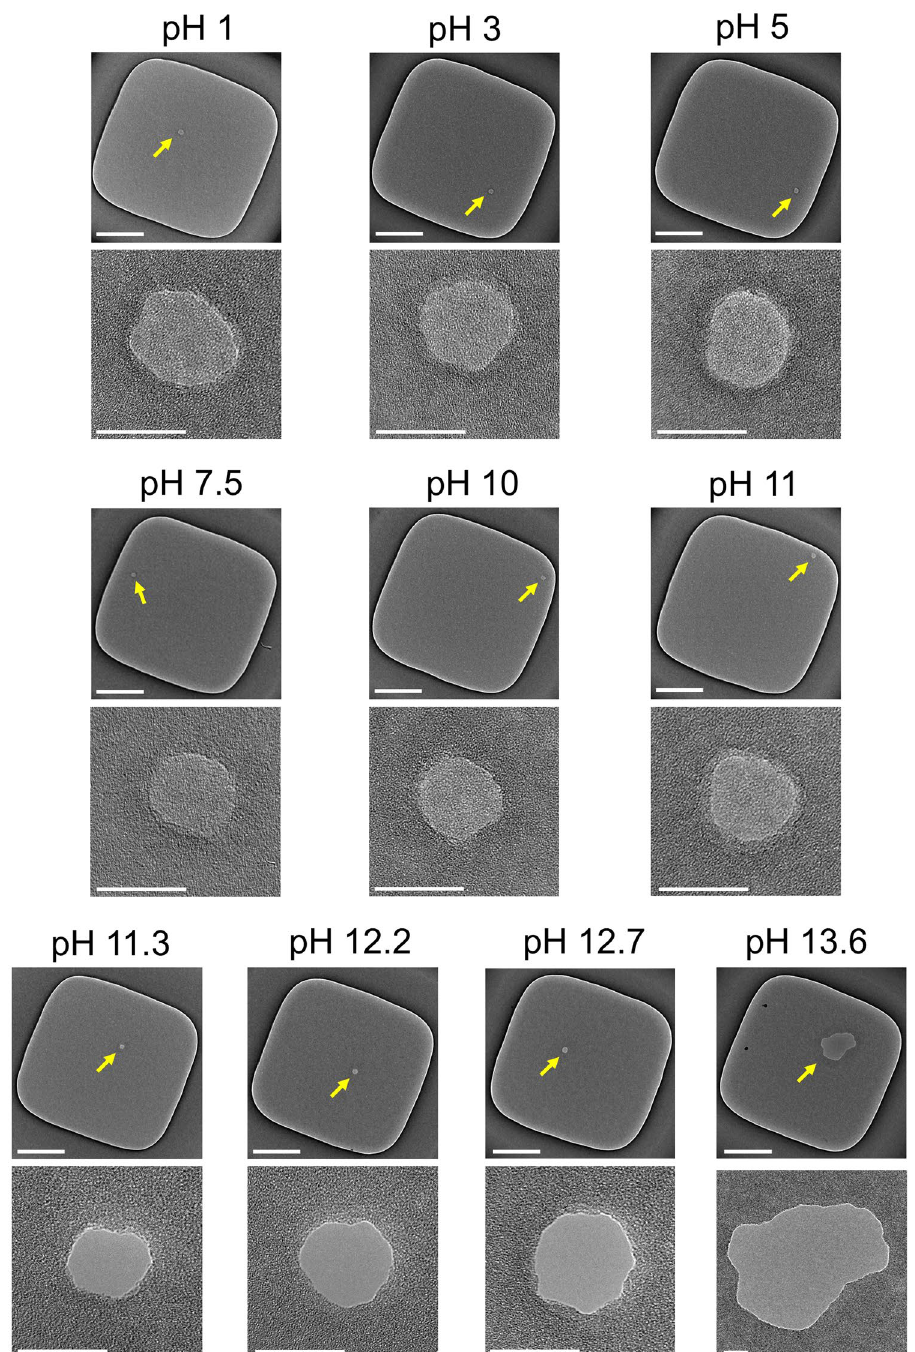
Figure 2. TEM images of SiN membranes after CBD under various pH conditions. An image of the entire membrane and a magnified view of the area around the created defect or nanopore are shown in each image set. Defective portions or nanopores are indicated by yellow arrows. The thickness of the SiN membranes was 20 nm, and V cis and V trans were set at 20 V and 0 V during CBD, respectively. I cutoff was set at 1 μ A. Scale bars for the images of the entire membranes are 200 nm, and those for the magnified views are 20